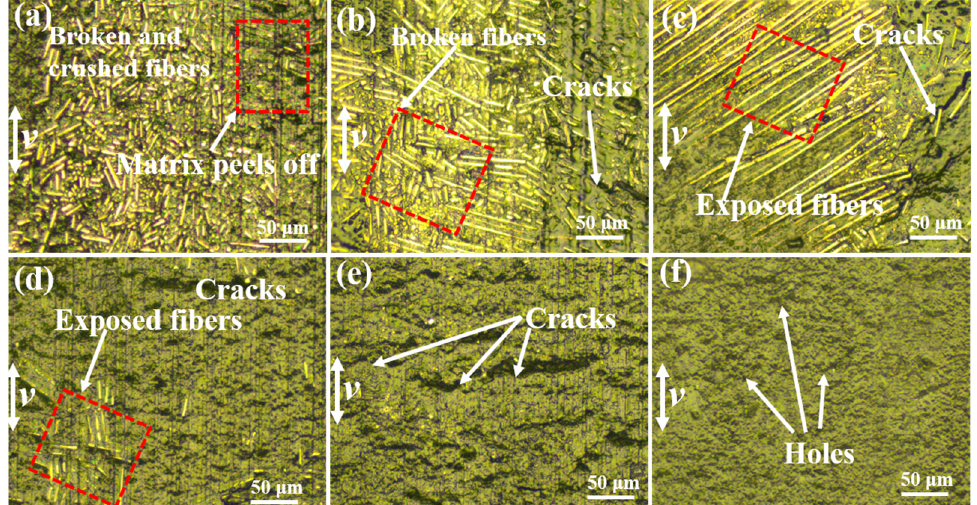
Figure 7. Optical images of worn surface of composites containing different contents of FGr@MoS 2 under room temperature: ( a ) FGr@MoS 2 -0; ( b ) FGr@MoS 2 -0.3; ( c ) FGr@MoS 2 -0.6; ( d ) FGr@MoS 2 -0.9; ( e ) FGr@MoS 2 -1.2; ( f ) FGr@MoS 2 -1.5.